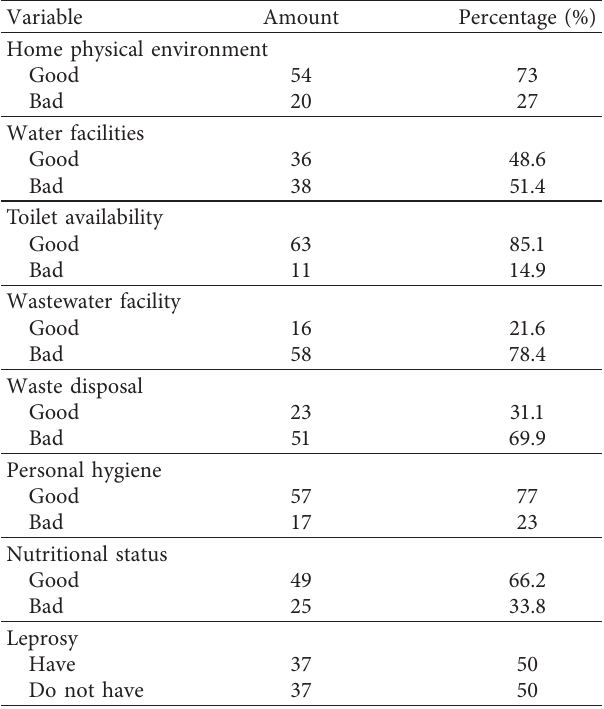
Table 1: Characteristics of research